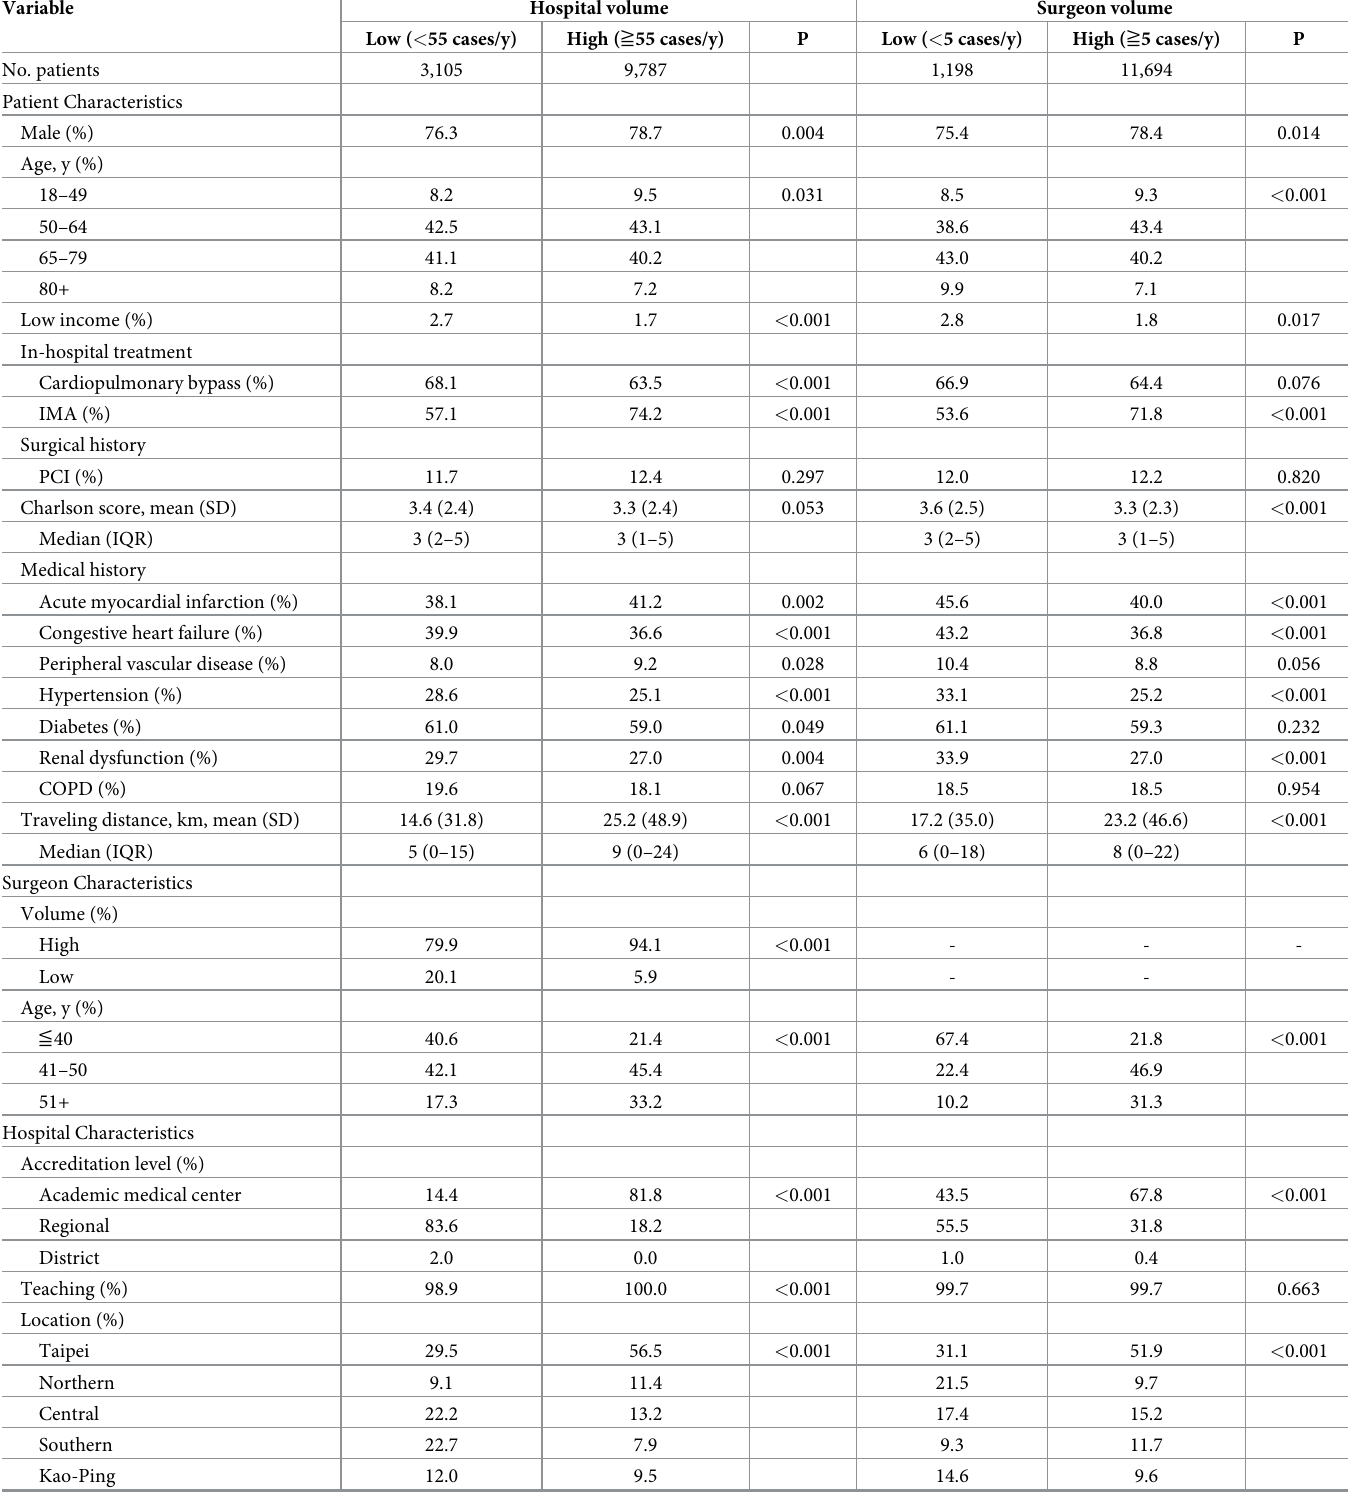
Table 2. Comparison of patient, surgeon, and hospital characteristics by hospital and surgeon